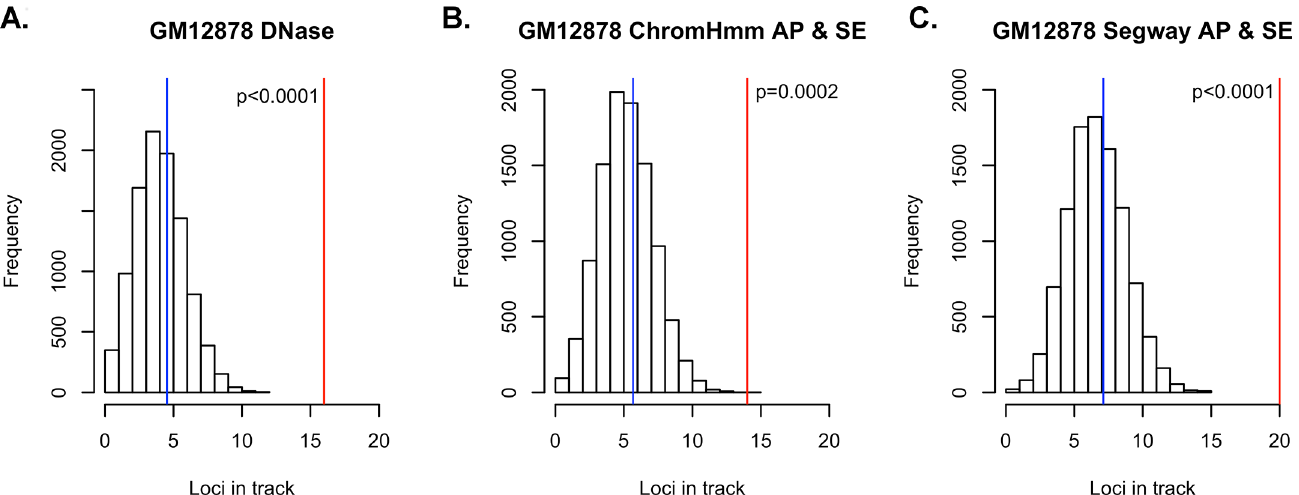
Fig 2. Overlap of lymphoma risk SNPs with regulatory regions in GM12878. The histograms represent the distribution of how many random loci overlap a specific annotation. The blue represents the mean of the empirical null distribution while the red line represents the real number of loci from the lymphoma and CLL GWAS that overlap the specific regulatory annotation. A, Overlap of SNPs with DNase hypersensitivity regions in GM12878. B, Overlap of SNPs with active promoters and strong enhancers as annotated by ChromHMM in GM12878. C, Overlap of SNPs with active promoters and strong enhancers as annotated by Segway in